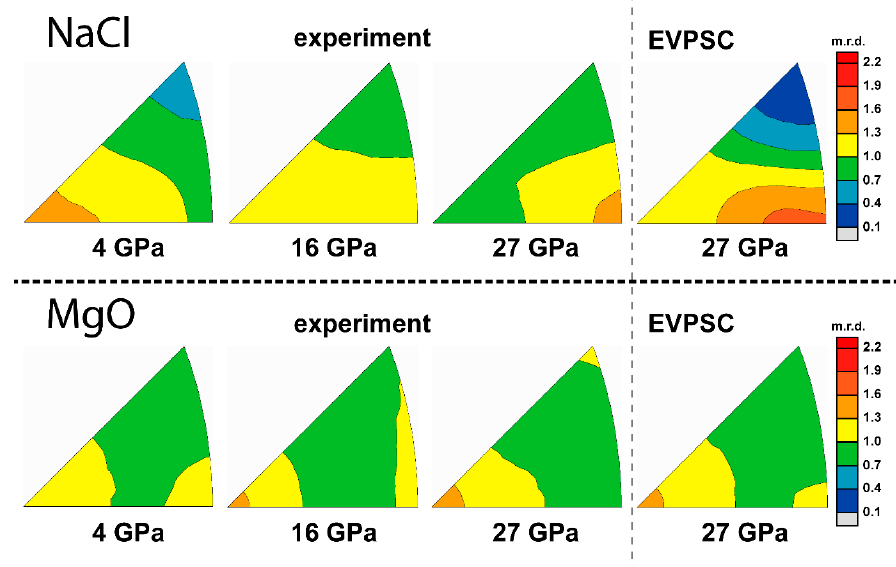
Figure 9. IPFs of experimental and modeled textures of 30% MgO + 70% NaCl. Scale bar is given in multiples of random distribution (m.r.d.)